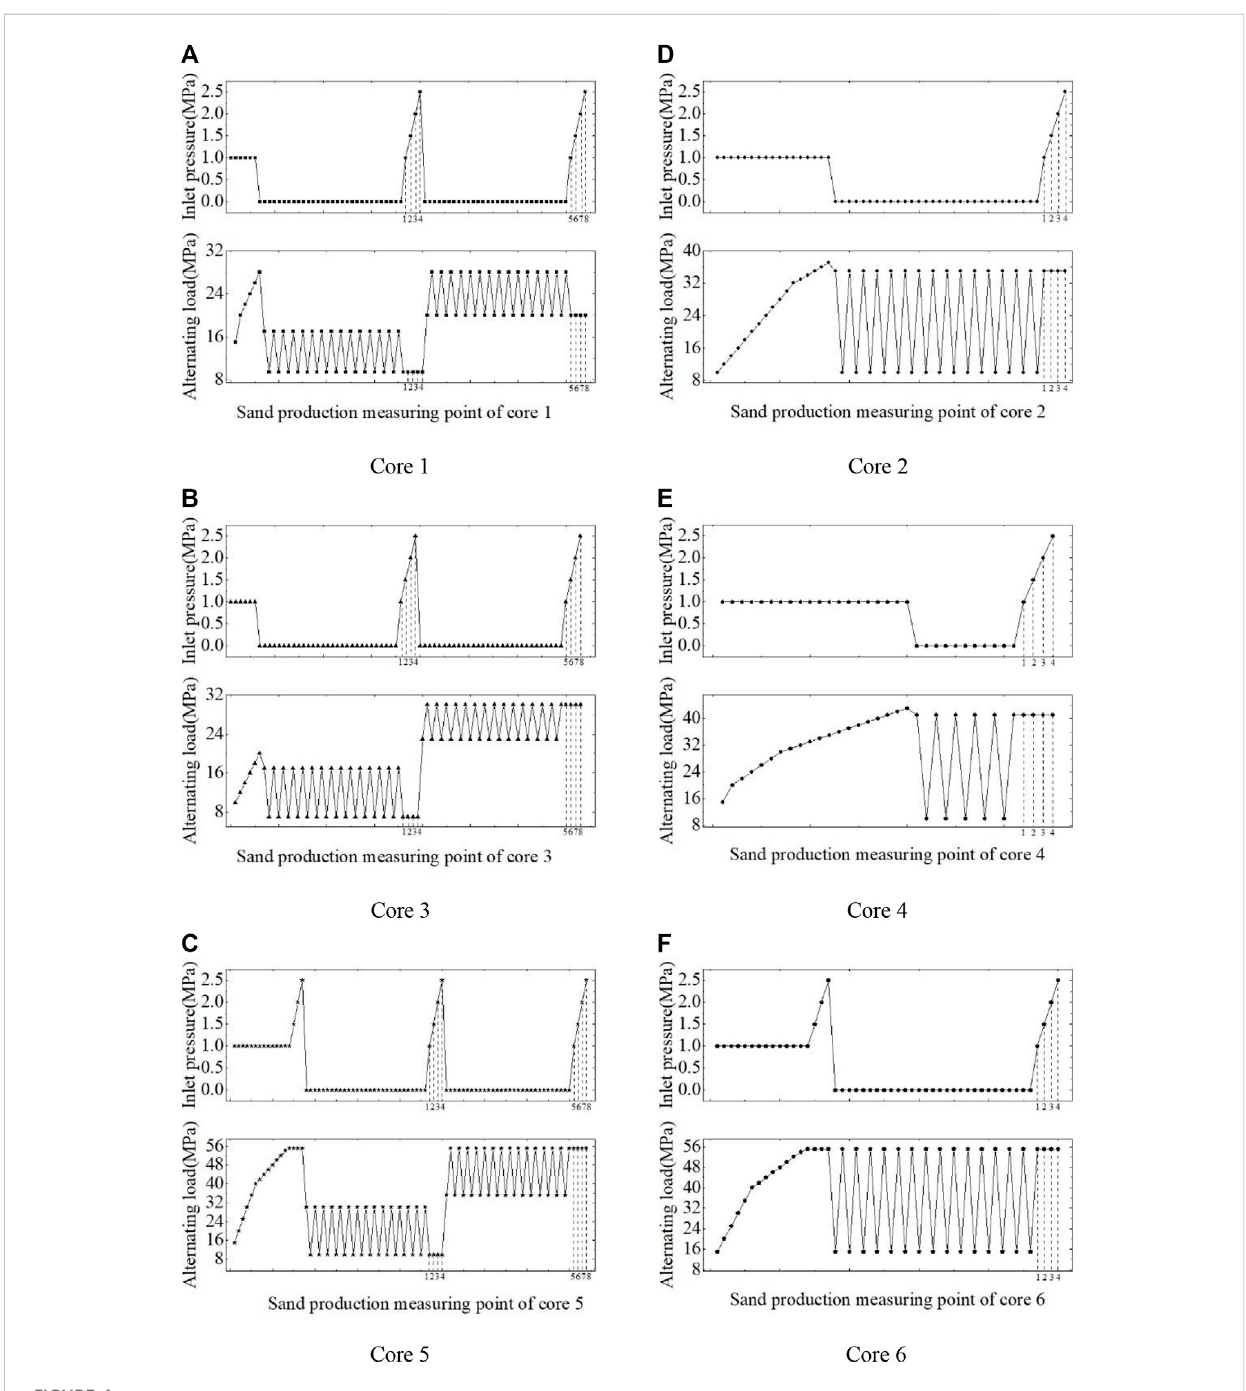
FIGURE 4 Core inlet pressure and alternating load